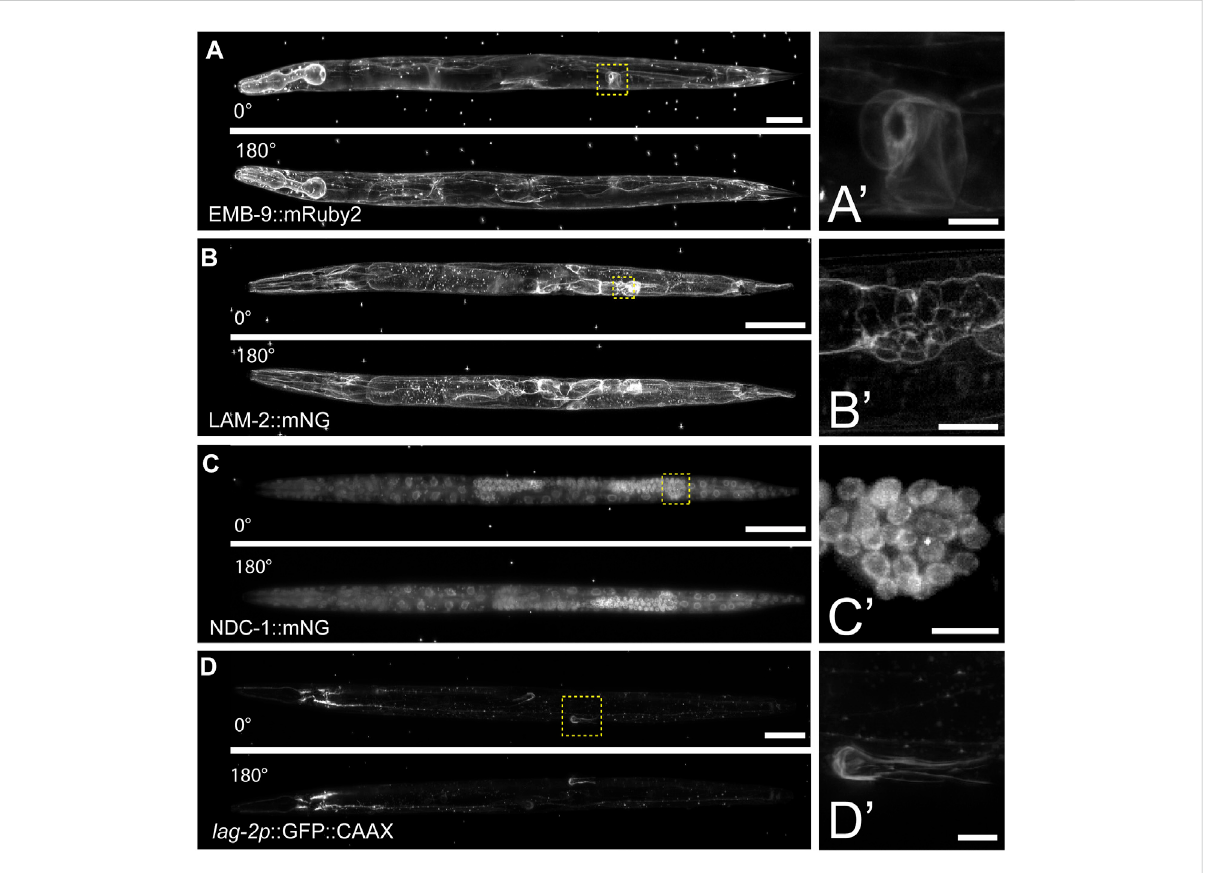
FIGURE 3 Multiview imaging of endogenously-tagged proteins in C. elegans young adults and larvae on a Zeiss Lightsheet 7 with a vertical mount. (A) Projected fl uorescentimagesfromtwoviewpointsontheZeissL7showingendogenously-taggedtypeIVcollagen(EMB-9:mRuby2)inayoungadult hermaphrodite. The images were acquired from two angles 180 ° apart using a 20x NA 1.0 water dipping lens (z-step = 0.30 µm, 561 nm laser 2% power and 30 ms exposure). (B) Two projected images from LSFM sectioning of endogenously-tagged laminin (LAM-2:mNG) in an L4hermaphrodite.Theimageswereacquiredfromtwoangles180 ° apartusinga20xNA1.0waterdippinglens(z-step=0.30 µm,488 nmlaser1.5% power and 30 ms exposure). (C) Two projected images showing endogenously-tagged nucleoporin (NDC-1:mNG) in an L4 hermaphrodite. The images were acquired from two angles 180 ° apart using a 20x NA 1.0 water dipping lens (z-step = 0.30 µm, 488 nm laser 2% power and 50 ms exposure). (D) Two projected images showing distal tip cell (DTC) speci fi c expression of membrane-tethered GFP in an adult hermaphrodite. The images were acquired from two angles 180 ° apart using a 20x NA 1.0 water dipping lens (z-step = 0.30 µm, 488 nm laser 7% power and 40 ms exposure). Scale bar for all images is 50 μ m, 10 µm for inset. (A 9 – D 9 ) Magni fi ed insets of regions in the yellow dashed boxes in (A – D)